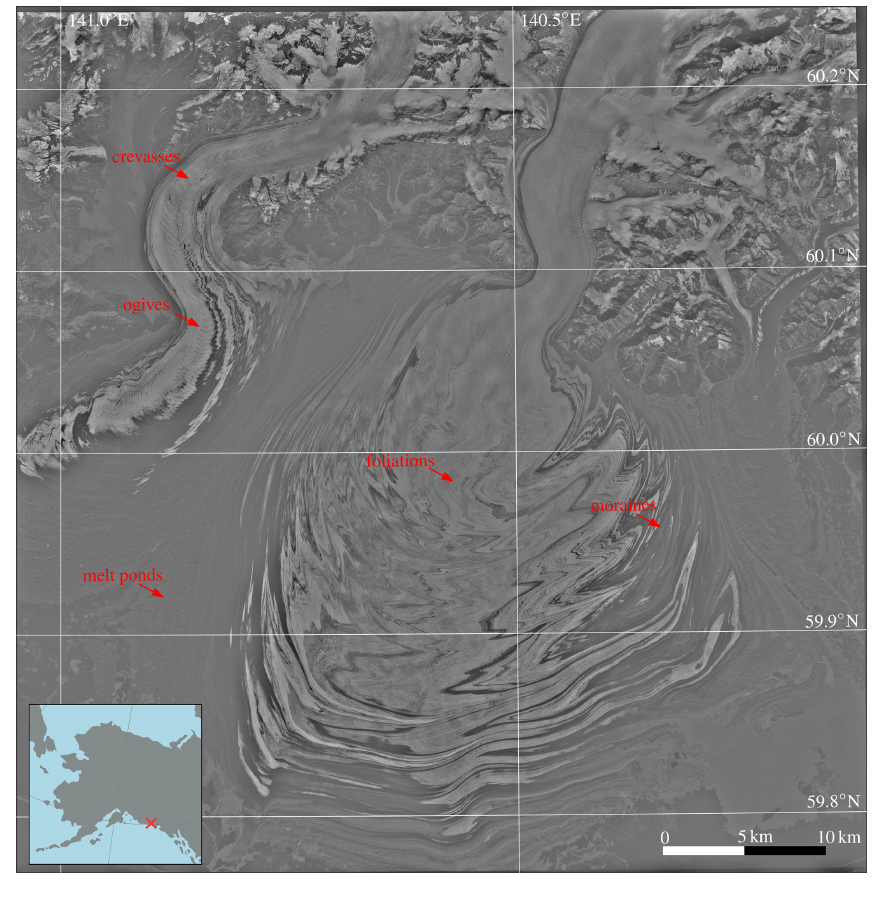
Figure D1. Sentinel-2 scene over Malaspina Glacier (center) and Agassiz Glacier (left) with annotations in red to enhance interpretation.